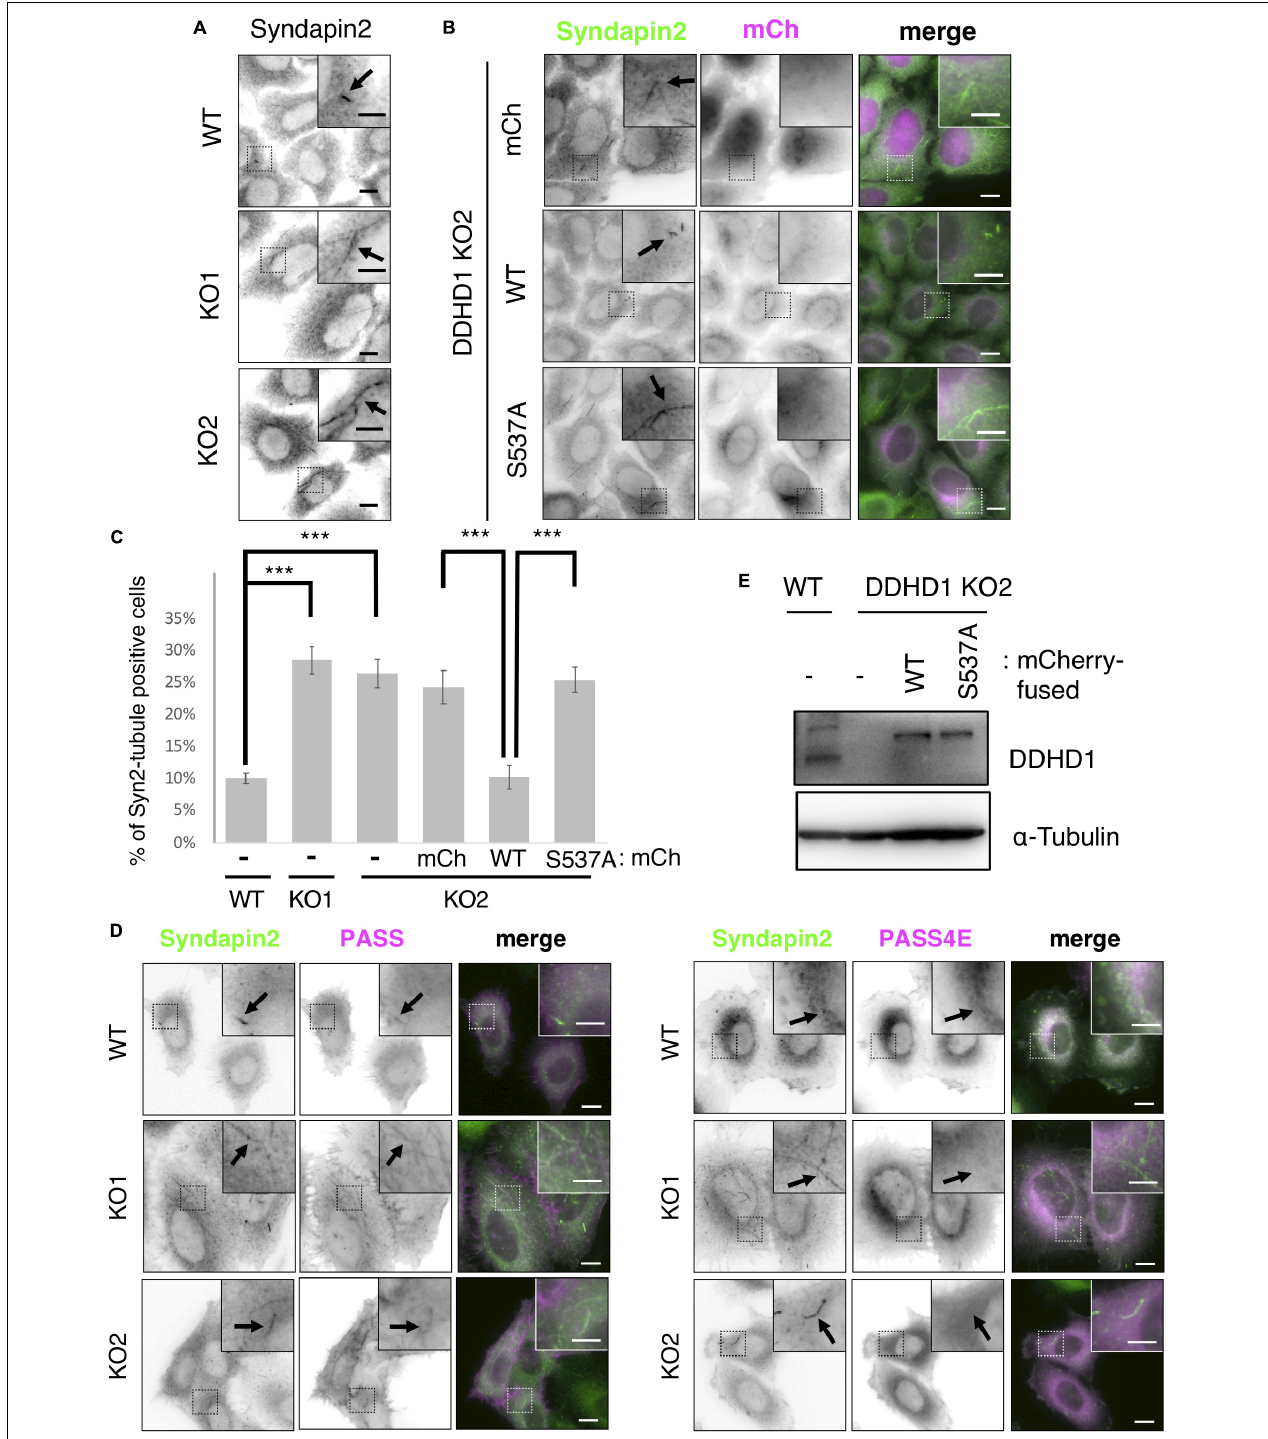
FIGURE 3 | Effect of DDHD1 KO on syndapin2-positive recycling tubules in HeLa cells. (A,B) HeLa cells and DDHD1 KO HeLa cells (A) , and DDHD1 KO HeLa cells-2 stably expressing mCherry, mCherry-DDHD1, or mCherry-DDHD1 S537A (B) were fixed and stained with anti-syndapin2 antibody. Higher magnification views of the boxed areas are shown in the inset. Scale bars, 10 µ m; inset, 5 µ m. (C) Quantification of the data in panels (A,B) . The percentages of cells containing syndapin2-positive tubules of over 3 µ m are shown in the graph. At least 50 cells were examined in each experiment. *** p < 0.01 (Tukey test). (D) Expression level of endogenous DDHD1 in HeLa cells, mCherry-DDHD1, and mCherry-DDHD1 S537A in DDHD1 KO HeLa cells were analyzed by Western blotting with the indicated antibodies. (E) HeLa cells and DDHD1 KO HeLa cells were transfected with plasmid for mRFP-PASS or mRFP-PASS 4E. At 24 h after transfection, cells were stained with anti-syndapin2 antibody. Higher magnification views of the boxed areas are shown in the inset. Scale bars, 10 µ m; inset, 5 µ m.